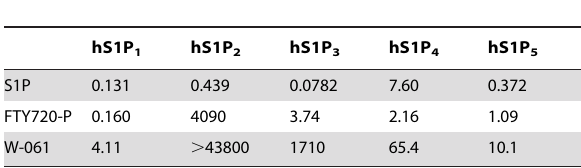
Table 1. Binding affinity of W-061 on S1P receptors.